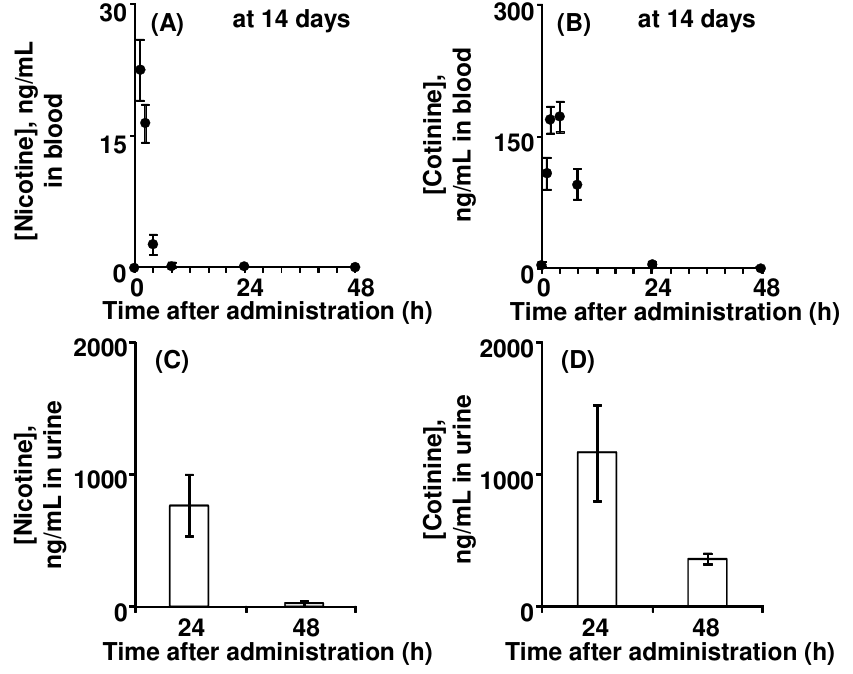
Figure 3. PK profiles in rats treated with nicotine. Nicotine (A, C) and cotinine (B, D) concentrations in blood (A, B) and urine (C, D) were determined in rats treated with nicotine (1 mg/kg/day) after the final administration of 14 daily